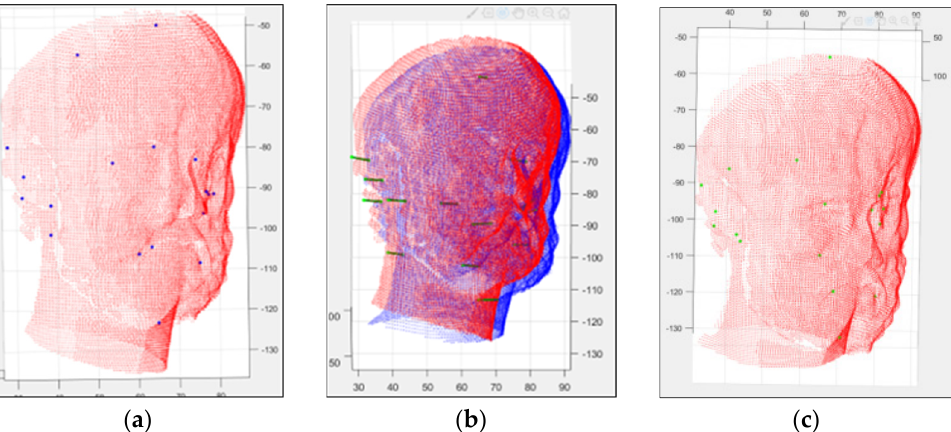
Figure 15. Aristotle sculpture: ( a ) detected keypoints in the 1st point cloud using new algorithm; ( b ) distribution of the matched keypoints with the new algorithm; ( c ) detected keypoints in the 2nd point cloud using new algorithm.